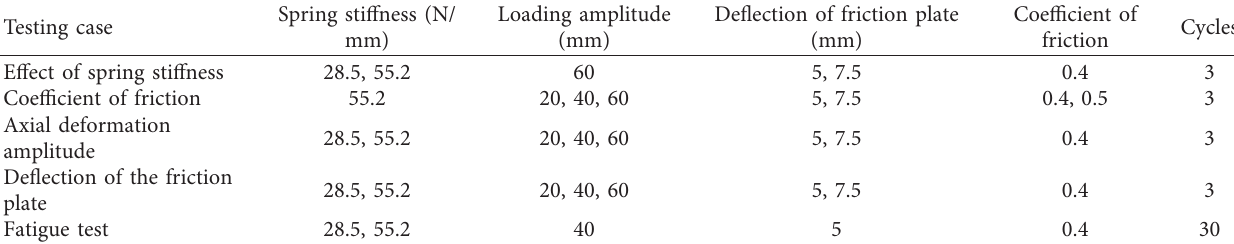
Table 3: Experimental loading